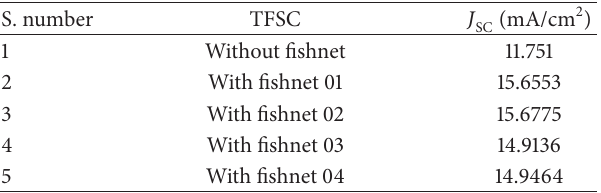
for TFSCs with and without the fishnet